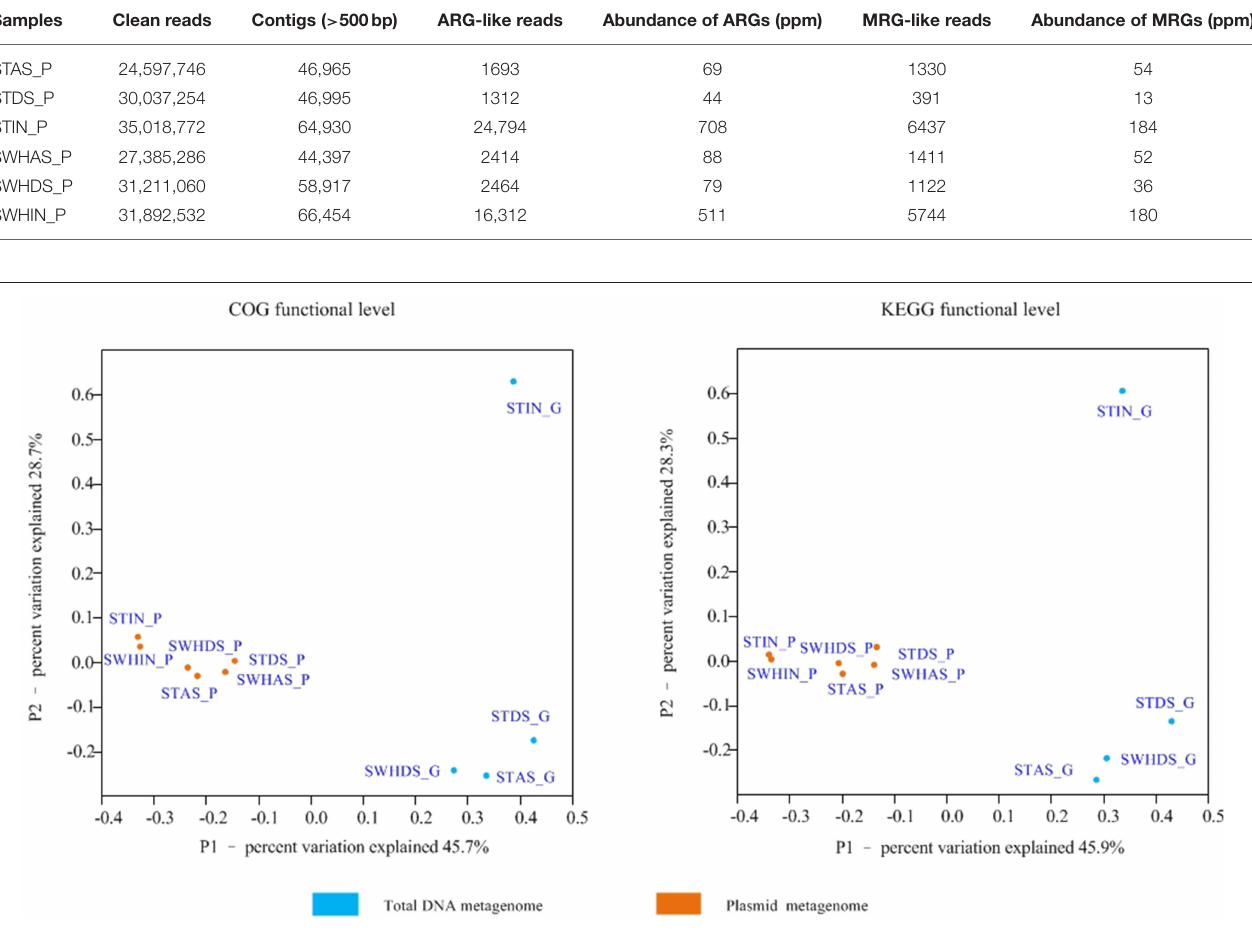
FIGURE 2 | PCoA analysis at the read level with the Bray-Cutis algorithm (based on the MG-RAST COG & KEGG functional level